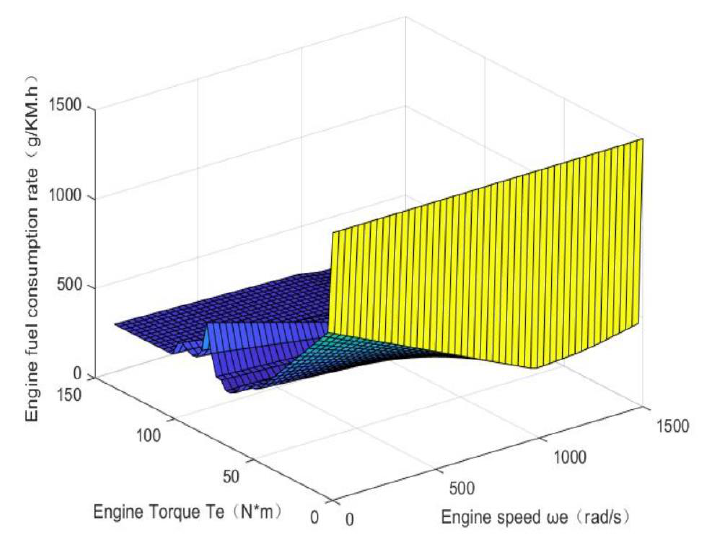
Figure 2. Engine fuel consumption rate.